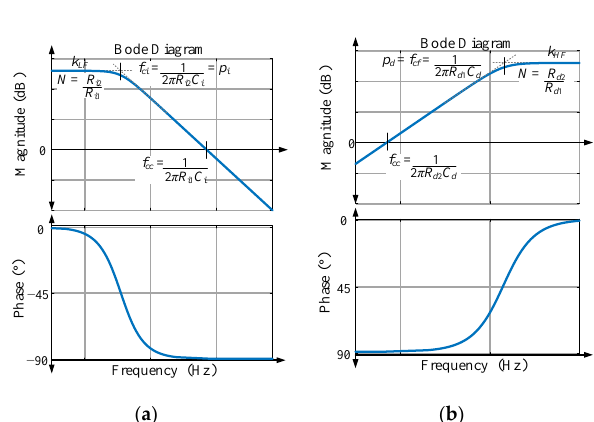
Figure 11. Frequency response with gain (top) and phase (below) ( a ) integral block; ( b ) derivative